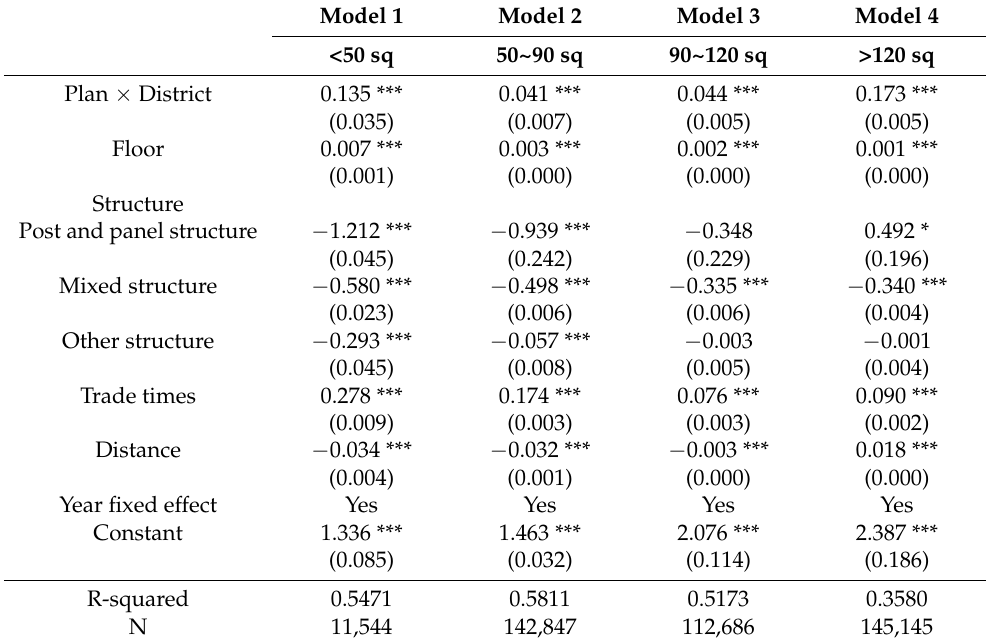
Table 6. The area heterogeneity of the impact of the construction of the National Big Data (Guizhou) Experimental Area on the residential transaction price.